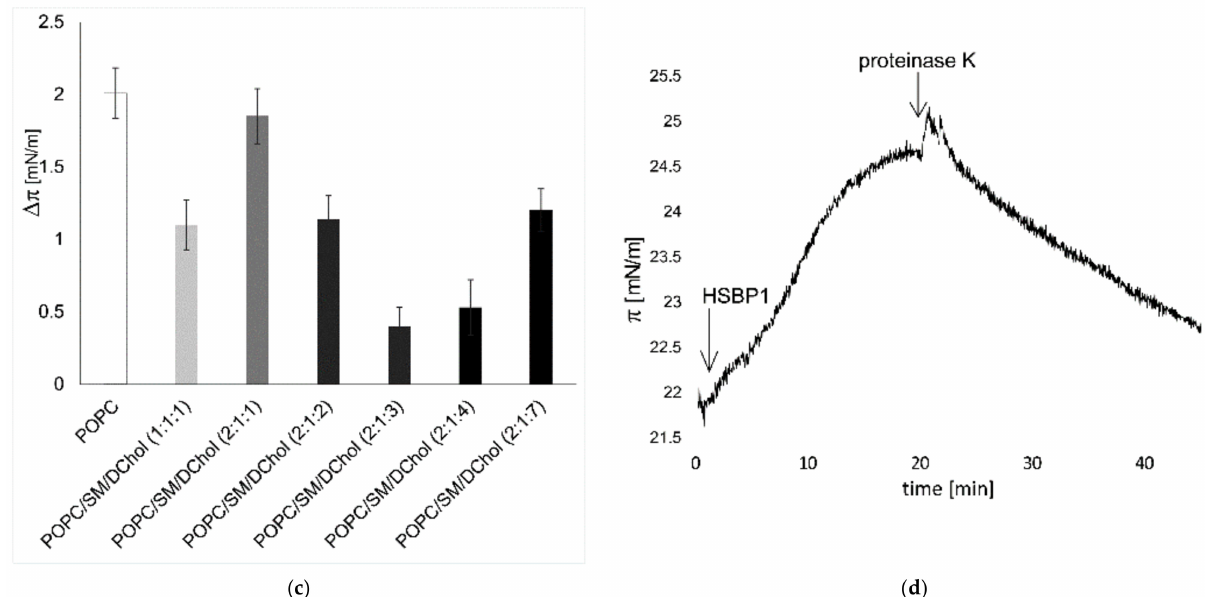
Figure 1. Lipid preference of HSPB1 measured by monolayer surface pressure. ( a ) HSPB1 was injected underneath the lipid monolayer of POPC and the surface pressure ( π i ) was measured after pressure equilibration. The black arrow indicates the time of injection. ( b ) Surface pressure change in DOPC or POPC monolayers five minutes following the addition of different amounts of HSPB1 underneath monolayers formed at an initial surface pressure of 22 mN/m. ( c ) Comparison of 1 µ M HSPB1-induced maximum surface pressure increase in monolayers of pure POPC and different ternary lipid mixtures of POPC, SM, and DChol ( π I = 22 mN/m). ( d ) Effect of proteinase K treatment on the interaction of HSPB1 with POPC monolayers. Arrows indicate the time of HSPB1 (1 µ M) and proteinase K (1 µ g/mL) injection underneath the monolayer. Solid and dashed lines represent polynomial fitted